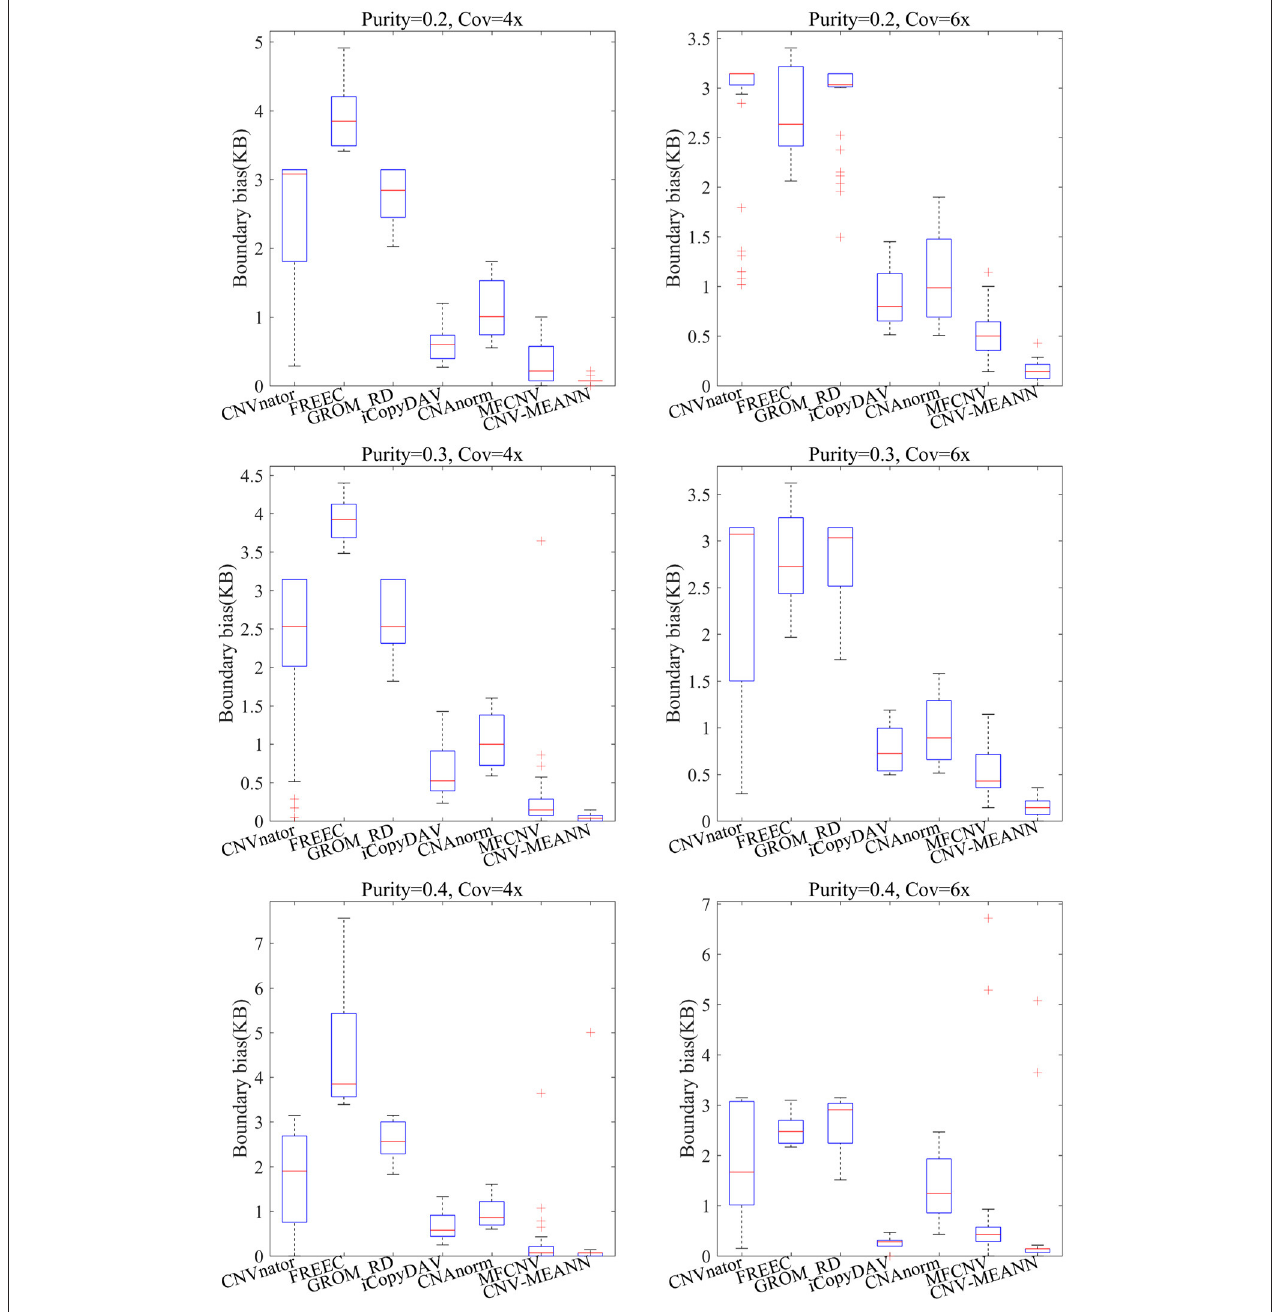
FIGURE 6 | Comparisons of the boundary bias between CNV-MEANN and six peer